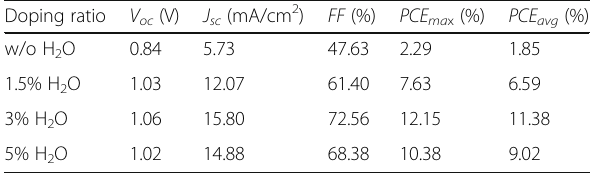
Table 1 The photovoltaic parameters of the champion PVSCs based on perovskite precursor solution with and without water additive